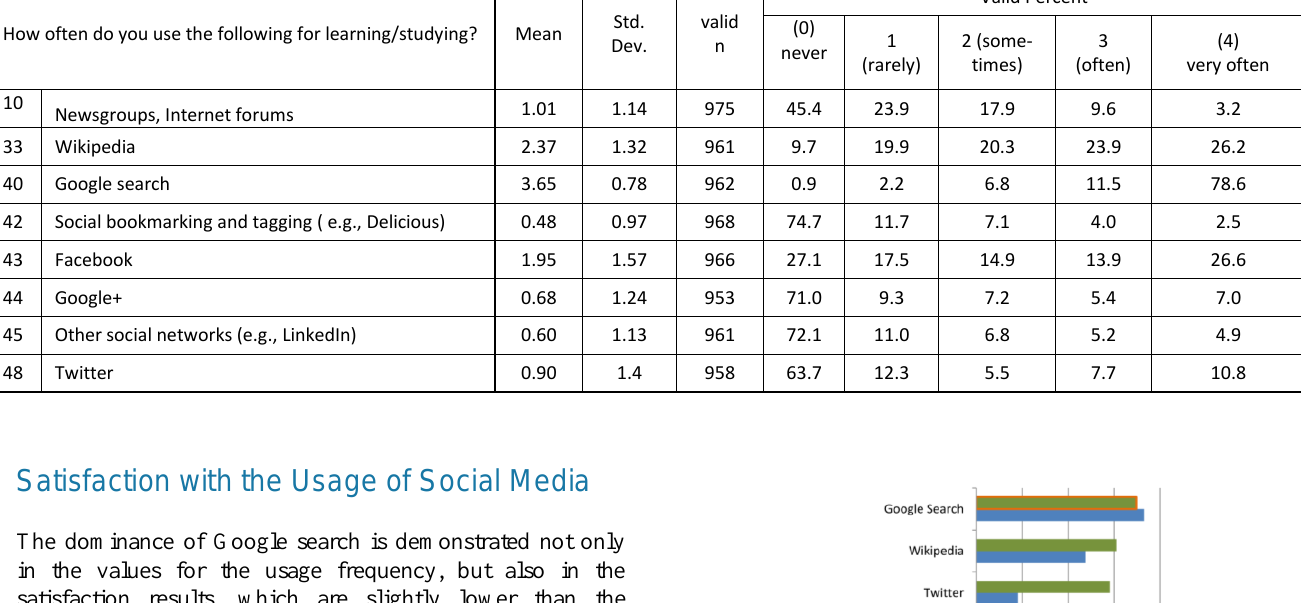
How often do you use the following for learning/studying?